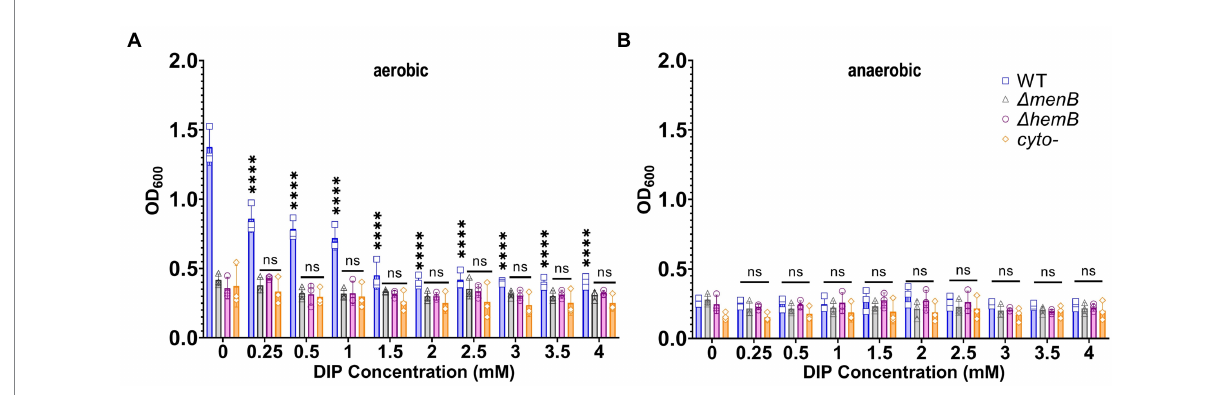
FIGURE 1 Growth of WT Staphylococcus aureus was diminished to the level of SCV growth under iron or oxygen limitation. (A) WT and SCV strains were treated with a range of DIP concentrations and cultured aerobically and growth was detected via OD 600 readings. DIP-induced growth suppression is only observed for WT S. aureus and only decreases to the level of baseline SCV growth. (B) WT and SCV strains were treated with a range of DIP concentrations and cultured anaerobically and growth was detected via OD 600 readings. No DIP-induced growth suppression could be observed for any strain tested. Each of the data points on the graph represents the average of triplicates on each day. Error bars represent standard deviation. A one-way ANOVA (Tukey’s multiple comparisons) was applied to understand the statistical significance of the differences between the control (untreated, 0 mM DIP) and the treatments (“ **** ” is the indication for p < 0.0001; “NS” is for non-significant data).